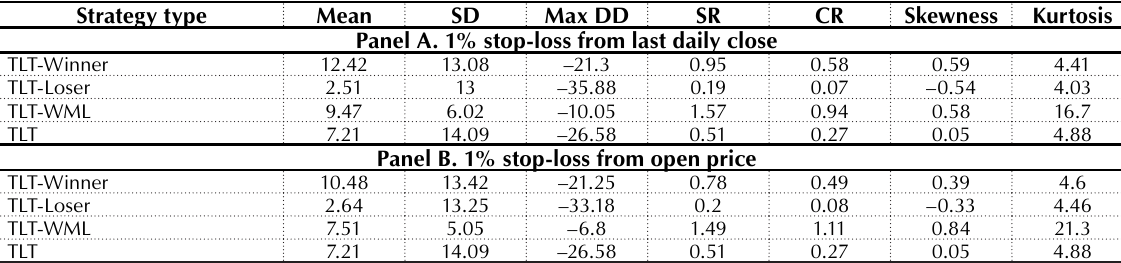
Table 2. TLT summary statistics with daily stop loss January 1, 2004 – October 13, 2015 Strategy